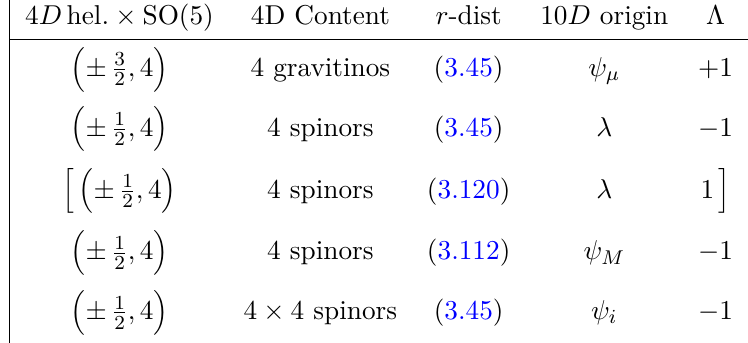
Table 1 . Four-Dimensional massless Fermi Modes. Λ denotes the eigenvalue that characterizes identical Fermi boundary conditions at the ends of the interval, as discussed in section 3. The alternative choice for the dilatino, with Λ = 1 , corresponds to the line within square